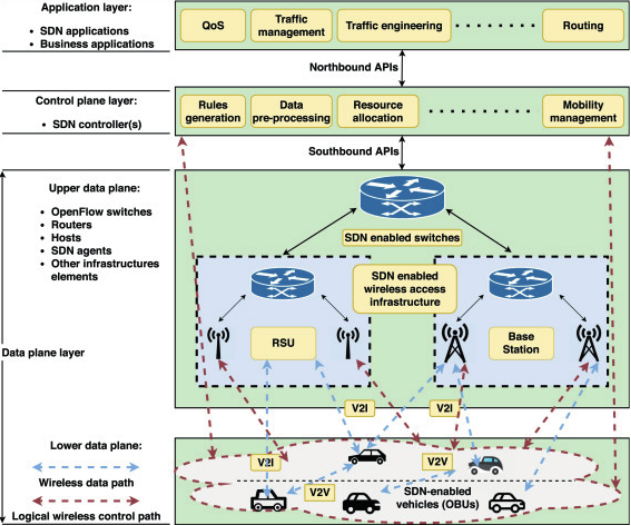
Fig. 7. SDVN architecture [32] .